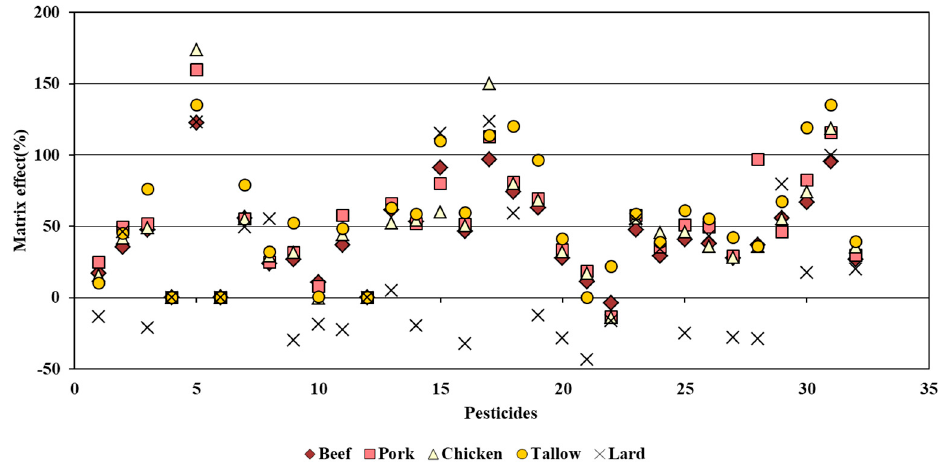
Figure 4. Matrix effects on the 32 compounds from beef, pork, chicken, tallow, and lard using the developed method.